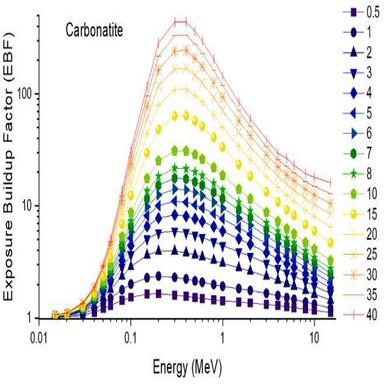
Variation of exposure buildup factor (EBF) values of carbonatite as a function of photon energy (MeV).